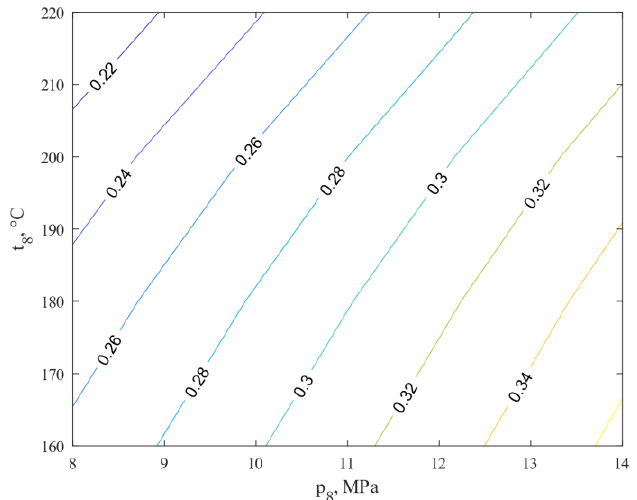
Figure 7. Influence of changes in pressure p 8 and temperature t 8 at the reactor inlet (Figure 3) on the chemical conversion efficiency η